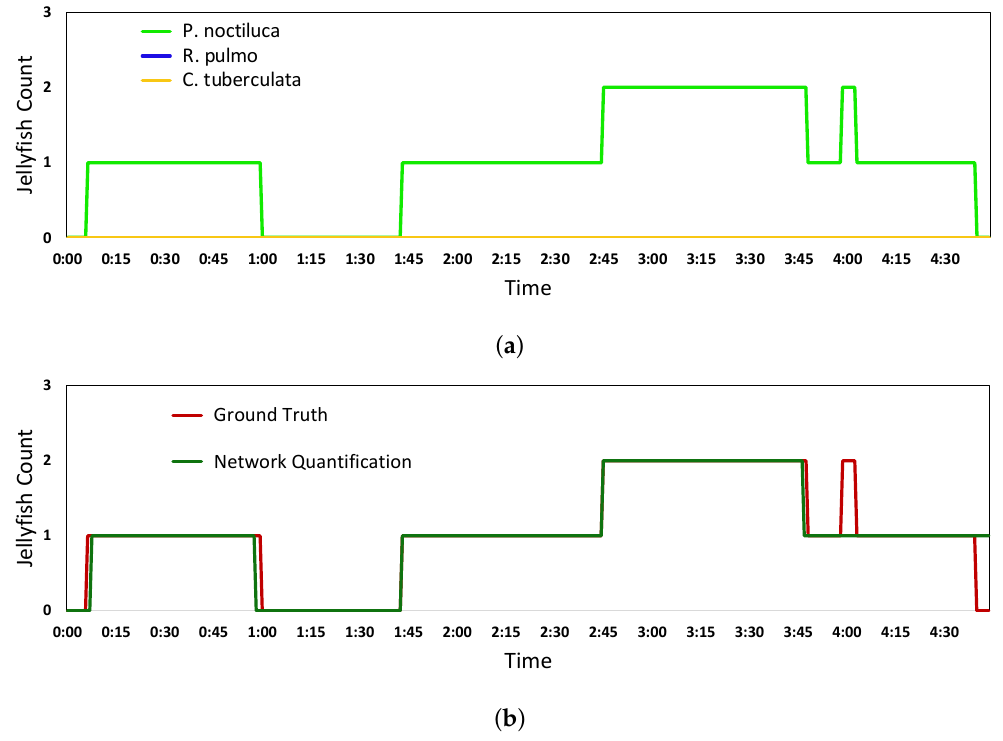
Figure 10. Results of the jellyfish count from manually generated ground truth ( a ) and its comparison against the results from the Inception ResNet V2 network quantification algorithm ( b